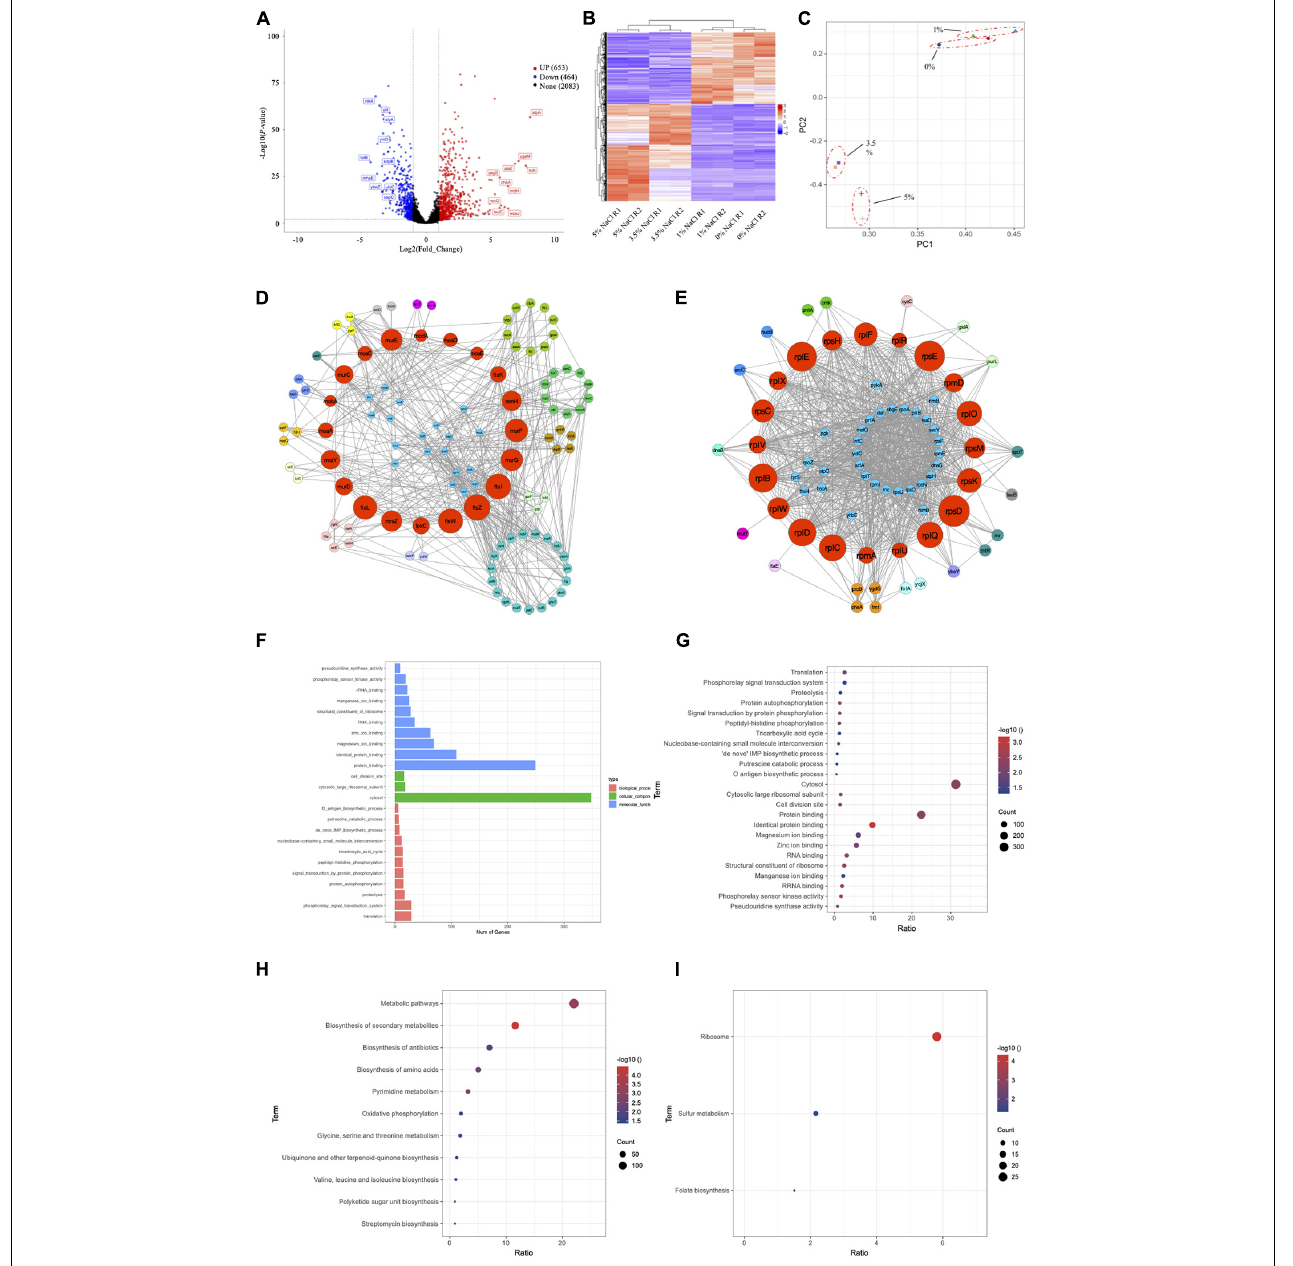
FIGURE 7 | Transcriptomic study of E. coli BW25113 under four NaCl concentrations of 0, 1, 3.5, and 5%. Since the phenotypes of E. coli under 0% and 1% NaCl are more consistent, while the phenotypes of E. coli under 3.5% and 5% NaCl are more similar, we combine 0% and 1% NaCl samples together as Group 1 and 3.5% and 5% NaCl samples together as Group 2 for the analysis. (A) Volcano plot for DEGs. (B) Heatmap plot for DEGs. (C) PCA analysis for group clusters. (D) Hub nodes among up-regulated genes. (E) Hub nodes among down-regulated genes. (F) Bar plot of GO term enrichment analysis. (G) Bubble plot of GO term enrichment analysis. (H) KEGG pathway enrichment for up-regulated genes. (I) KEGG pathway enrichment for down-regulated